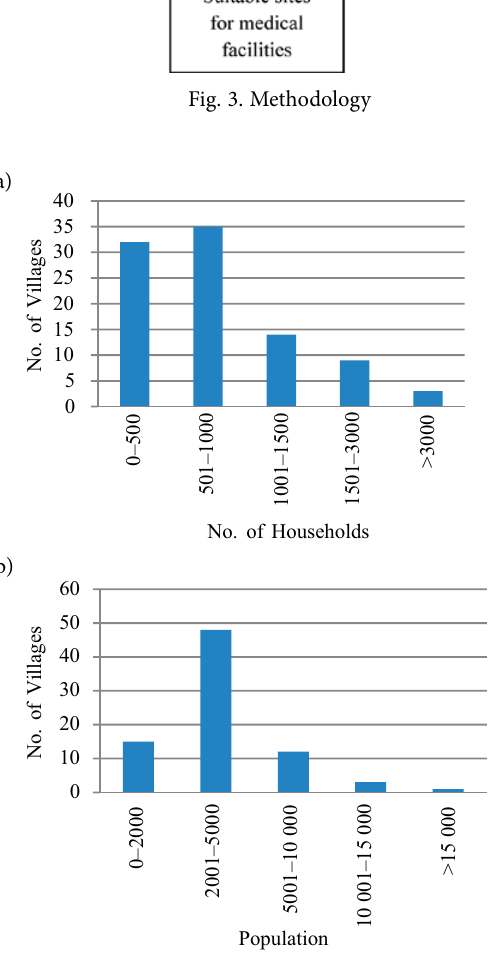
Fig. 2. Thematic maps: a) Landcover, b) Road, c) Drainage, d)